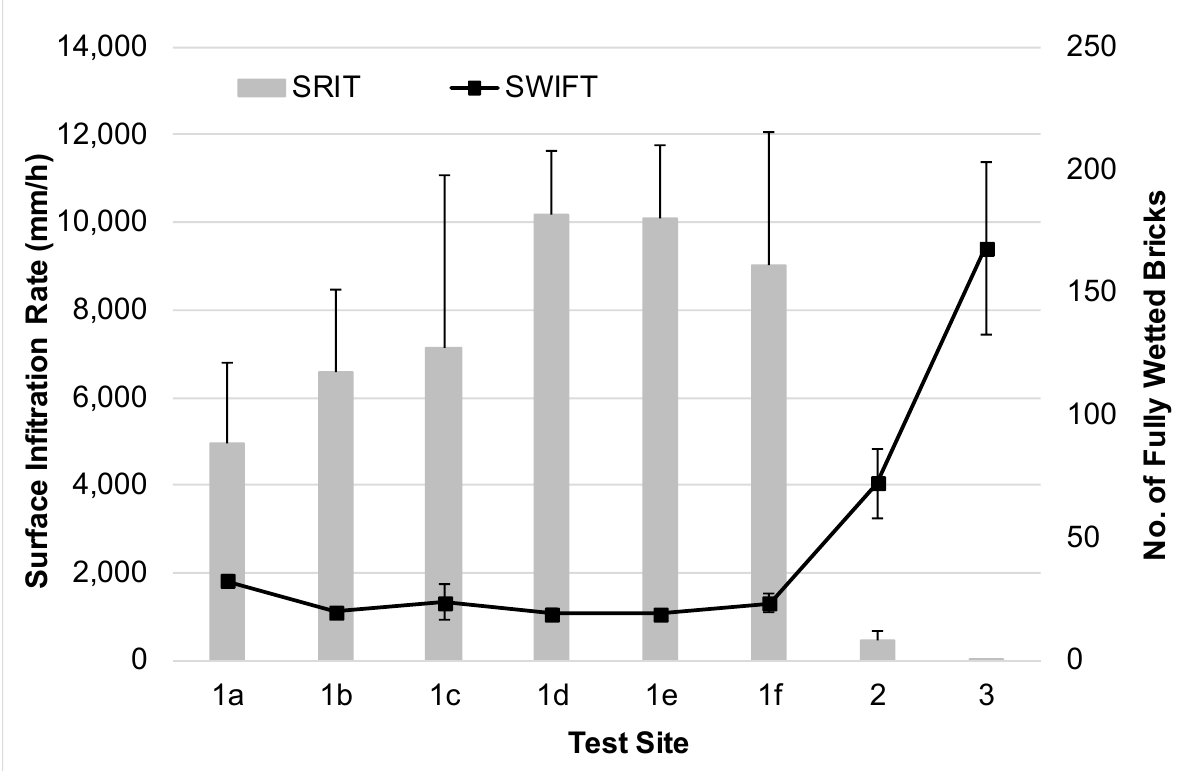
Figure 8. Comparison of PICP infiltration rates (± Standard Deviation) using SRIT and SWIFT